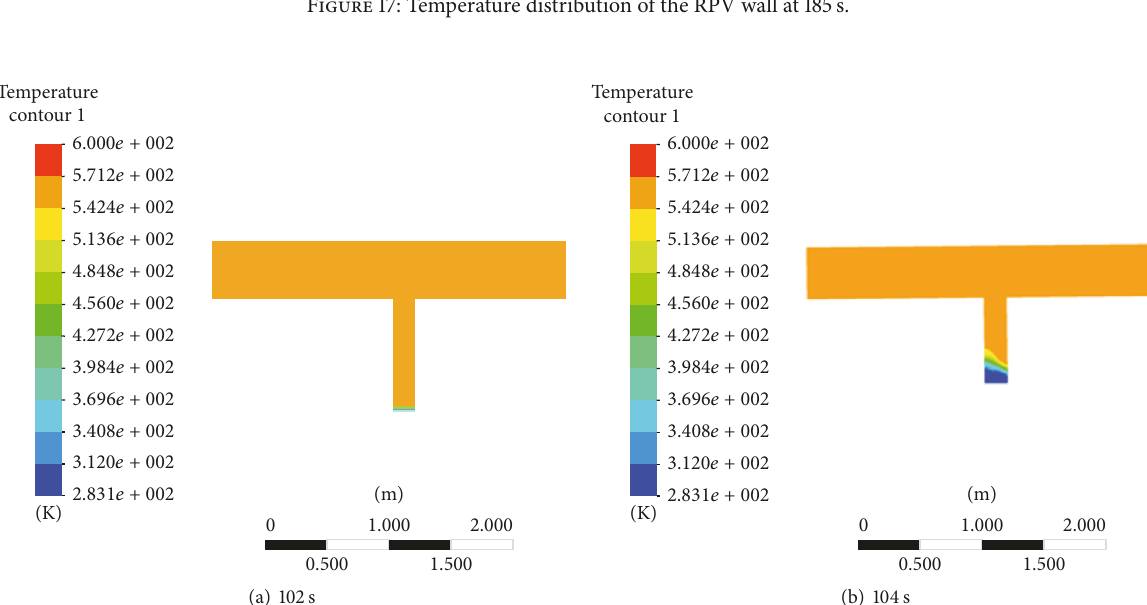
Figure 17: Temperature distribution of the RPV wall at 185s.